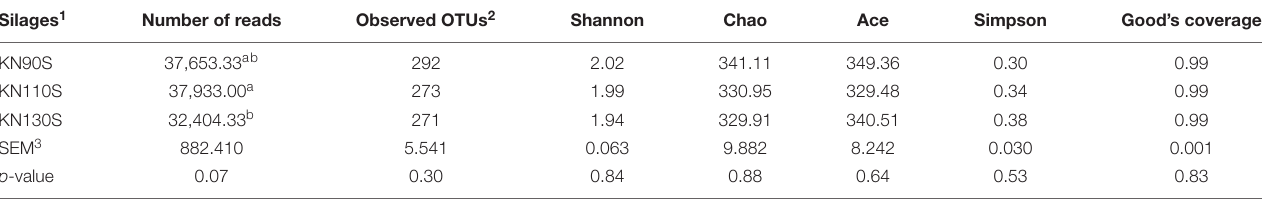
TABLE 4 | Alpha diversity of bacterial diversity for king grass silage. Silages 1